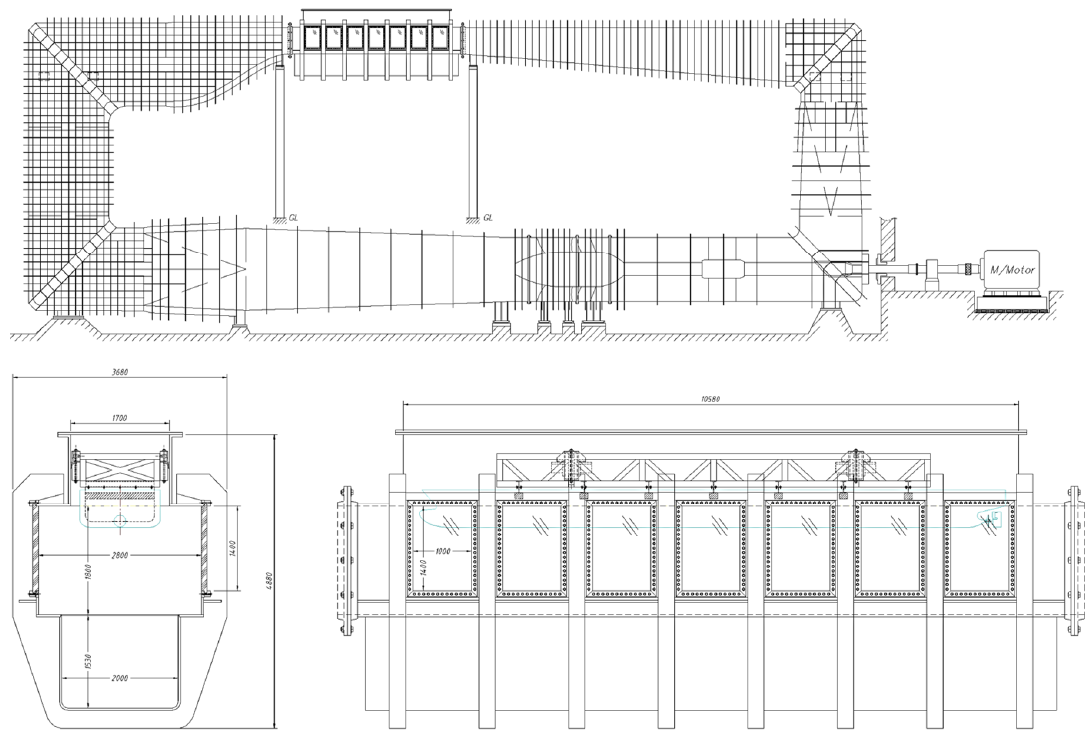
Figure 1. Schematic diagram of the KRISO large cavitation tunnel.